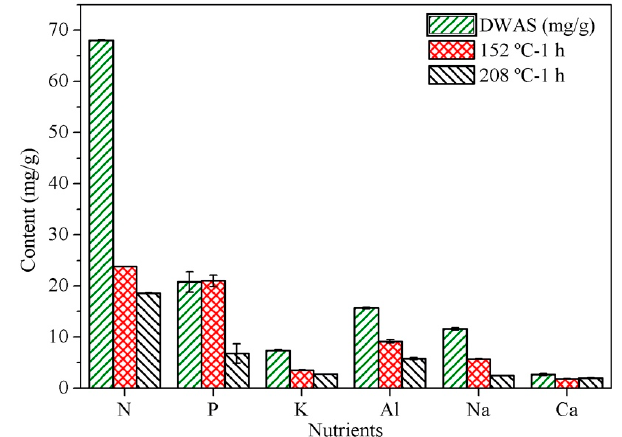
Figure 2. Contents in major nutrients and micronutrients of the carbons materials obtained by heating at 152 and 208 °C for 1 h. at 152 and 208 ◦ C for 1